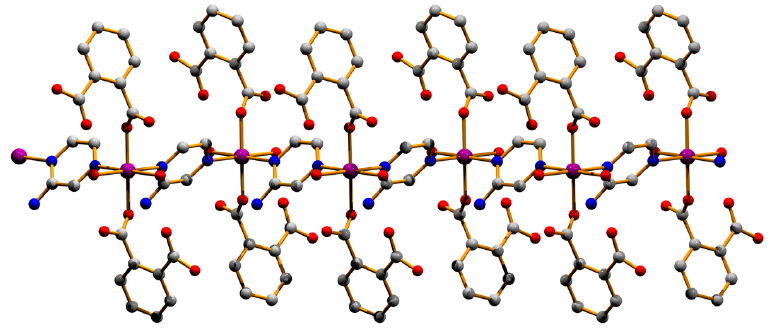
Figure 2. Propagation of one-dimensional polymer along (001) direction in 1 . One amino group of the aminopyrazine moiety with partial occupancy factor has been used to draw the figure.